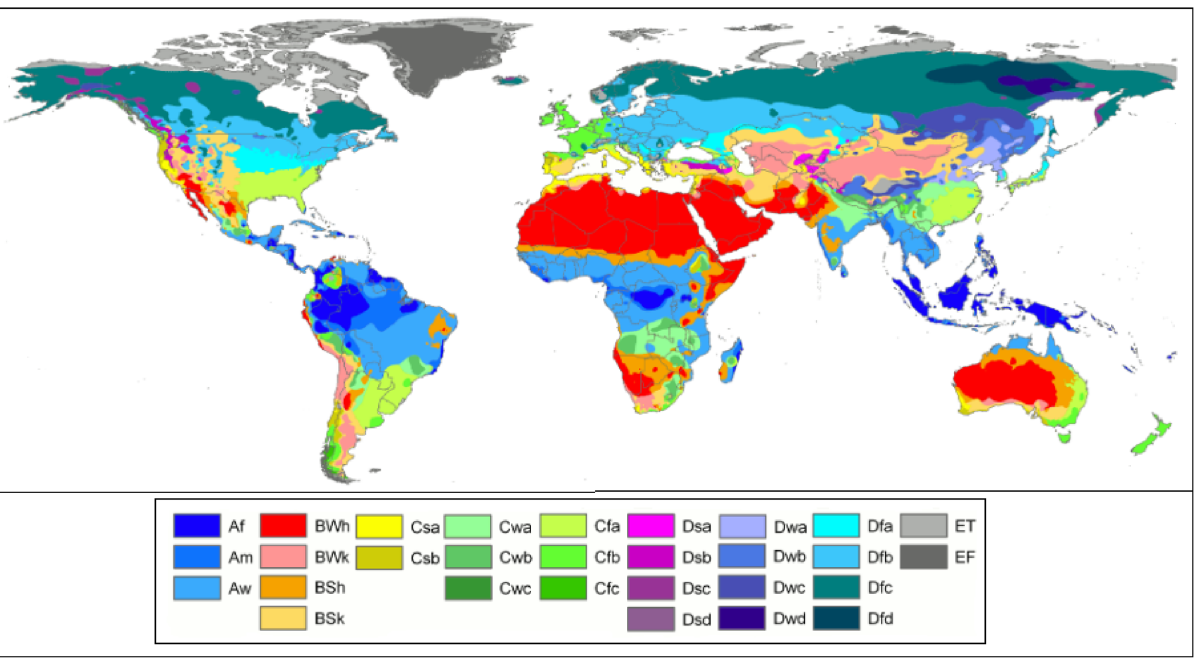
Figure 3. The Köppen climate classification of the world. (Zone A: tropical or equatorial zone; Zone B: arid or dry zone; Zone C: warm/mild temperate zone; Zone D: continental zone; Zone E: polar zone) 59